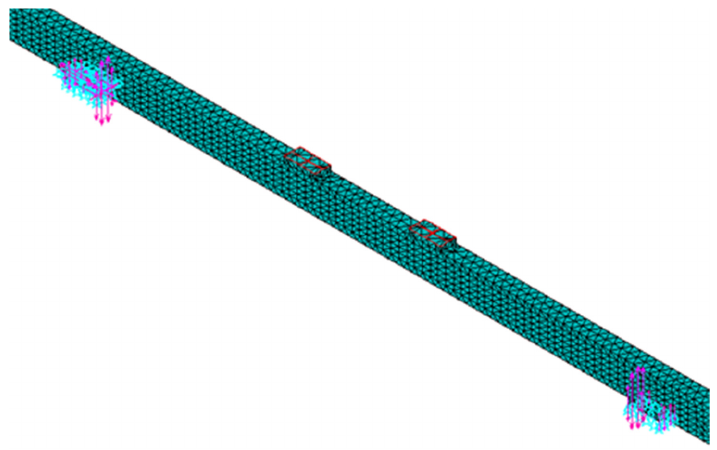
Figure 9. Meshed finite element model with loads and constraints.